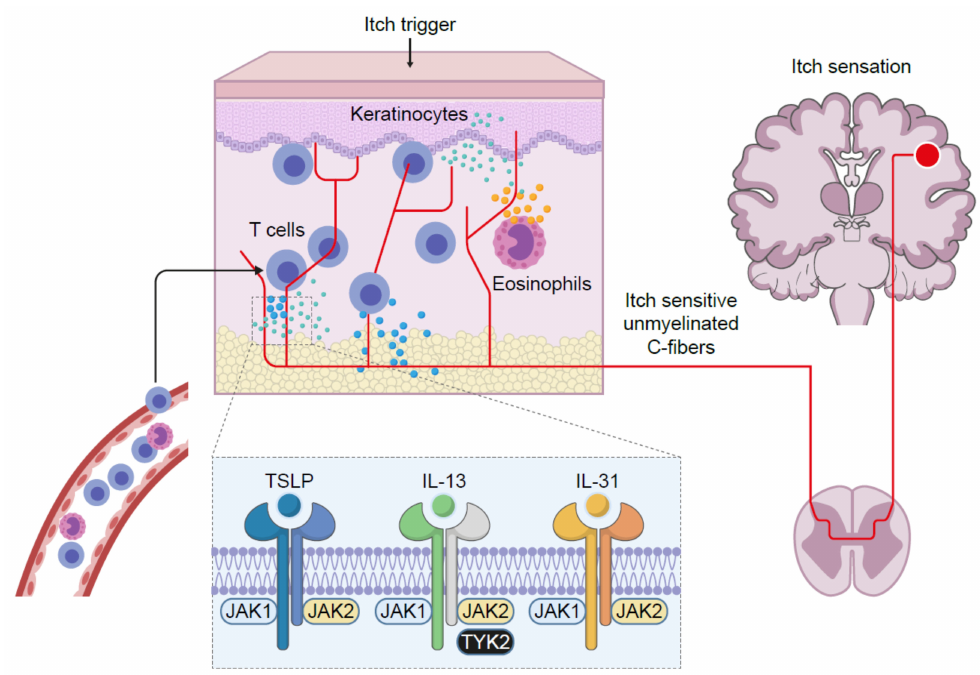
Figure 3. JAK-dependent signaling significantly contributes to chronic itch. IL: interleukin; JAK: Janus kinase; TSLP: thymic stromal lymphopoietin; TYK: tyrosine